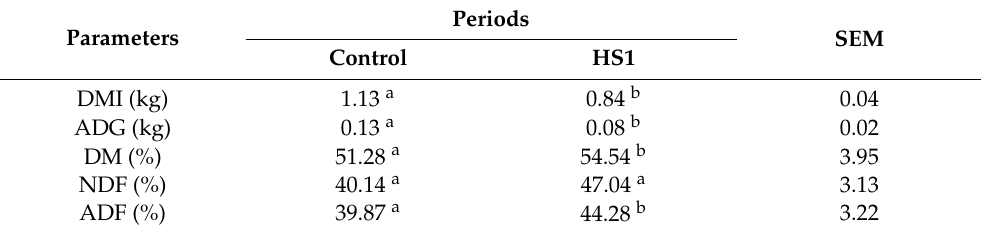
Table 4. The growth performance parameters of the goats in non- and heat stress periods.